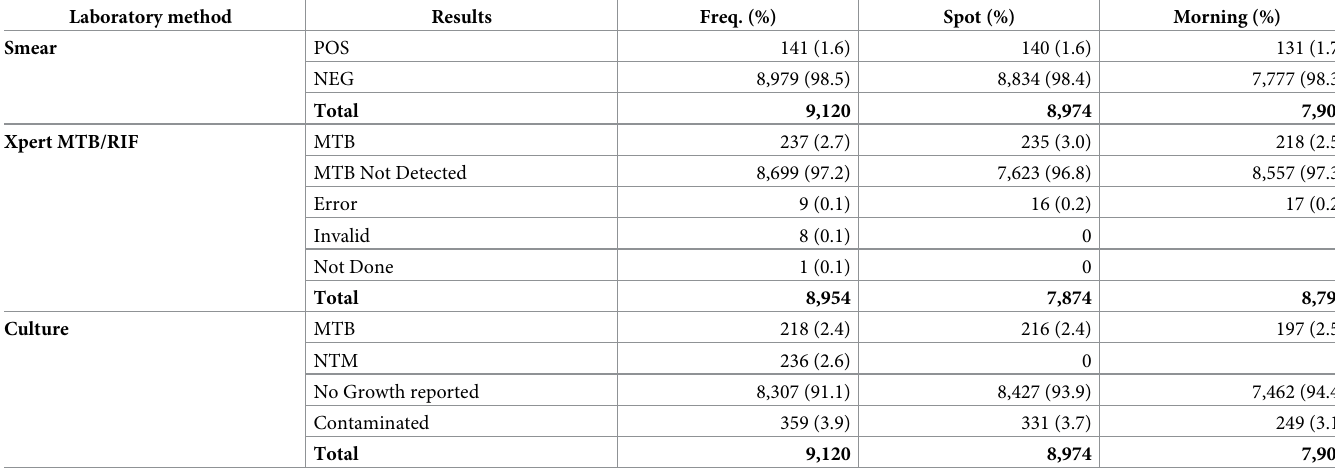
Table 2. Laboratory examination results.